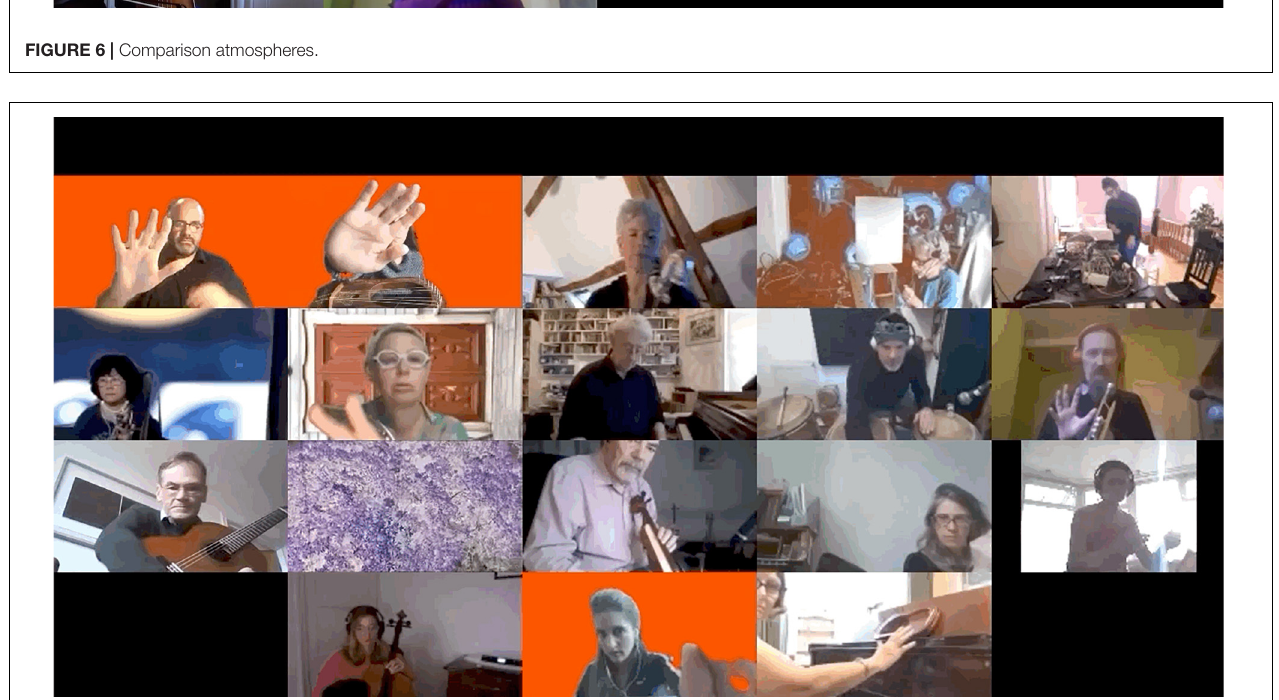
FIGURE 7 | Imitation and emergent bodily themes 1. The Gif version, highlighting musicians’ movement, can be found in the Supplementary Material .